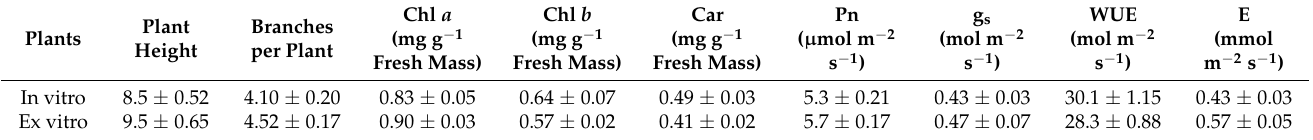
Table 6. Comparison of plant height, number of branches per plant, chlorophylls, carotenoids, net photosynthetic rate, stomatal conductance, water use efficiency, and transpiration rate between in vitro plants and ex vitro grown plants of L. speciosa .